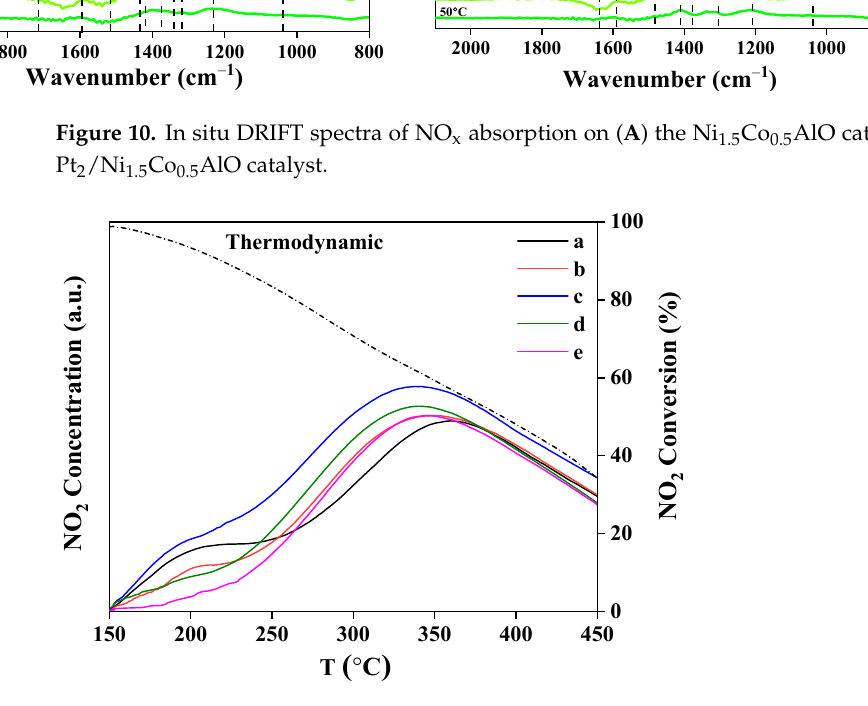
Figure 11. NO 2 concentration curves of NO temperature-programmed oxidation over Pt n /Ni 1.5 Co 0.5 AlO catalysts: (a) Ni 1.5 Co 0.5 AlO; (b) Pt 1 /Ni 1.5 Co 0.5 AlO; (c) Pt 2 /Ni 1.5 Co 0.5 AlO; (d) Pt 4 /Ni 1.5 Co 0.5 AlO; (e) Pt 6 /Ni 1.5 Co 0.5 AlO.